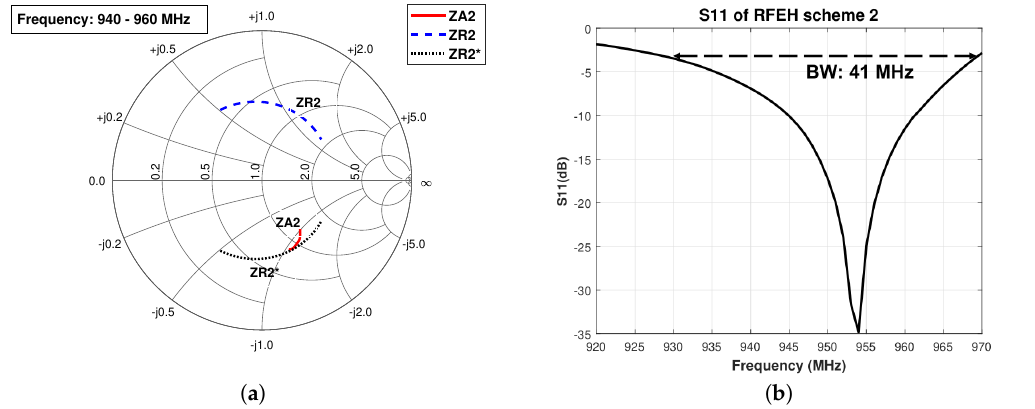
Figure 13. Measured impedance and S11 of the RFEH scheme 2: ( a ) Impedance and ( b )